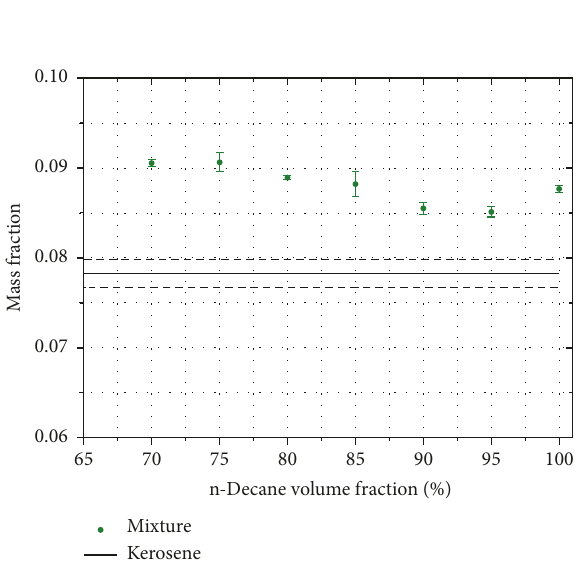
Figure3:ComparisonofmassfractionofCO2forthesurrogateand the kerosene burning.